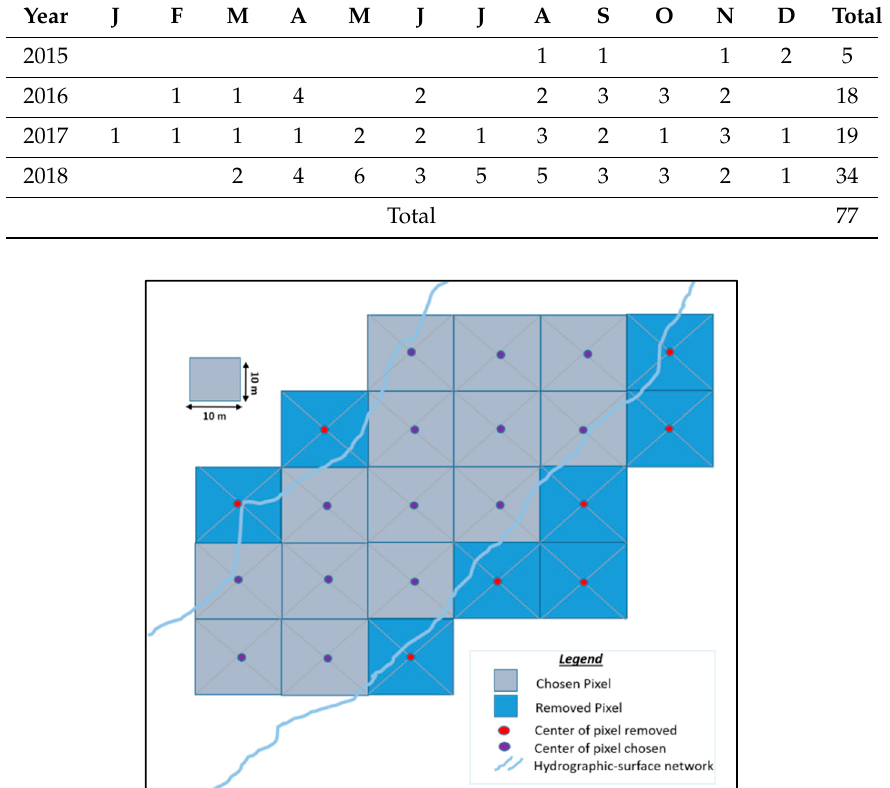
Table 3. Number of Sentinel-2 images of the study area obtained by month and year.